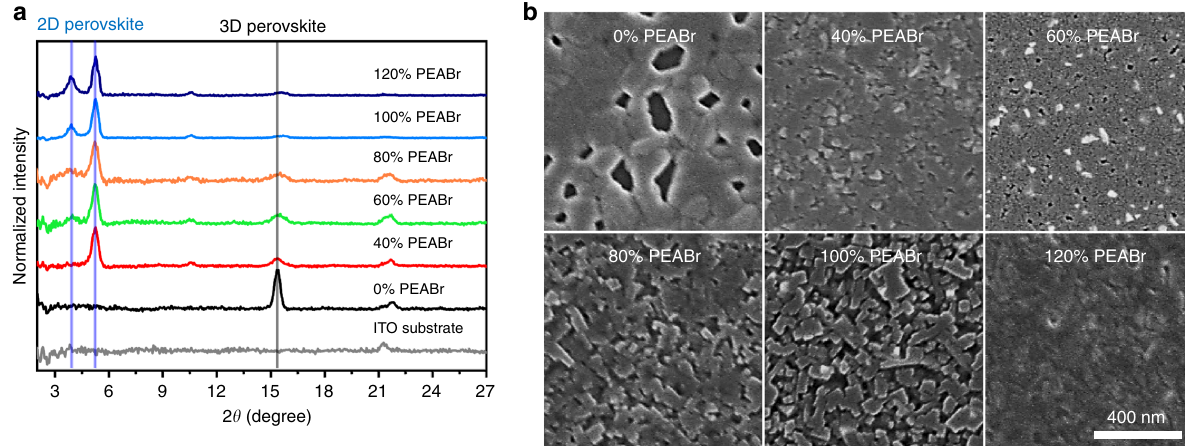
Fig. 2 Crystal structure and morphology of CsPbCl 0.9 Br 2.1 thin fi lms with different ratios of phenylethylammonium bromide (PEABr). a X-ray diffraction (XRD) patterns and b top-view scanning electron microscope (SEM) images at a size of 1 × 1 μ m